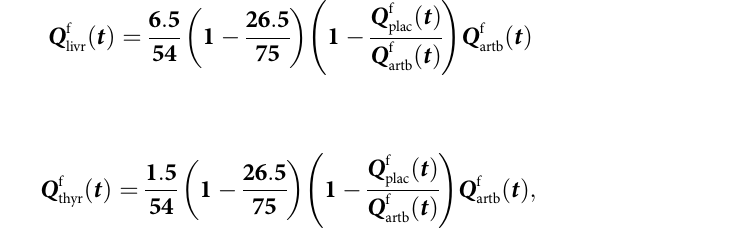
PLOS ONE | https://doi.org/10.1371/journal.pone.0215906 May 2,